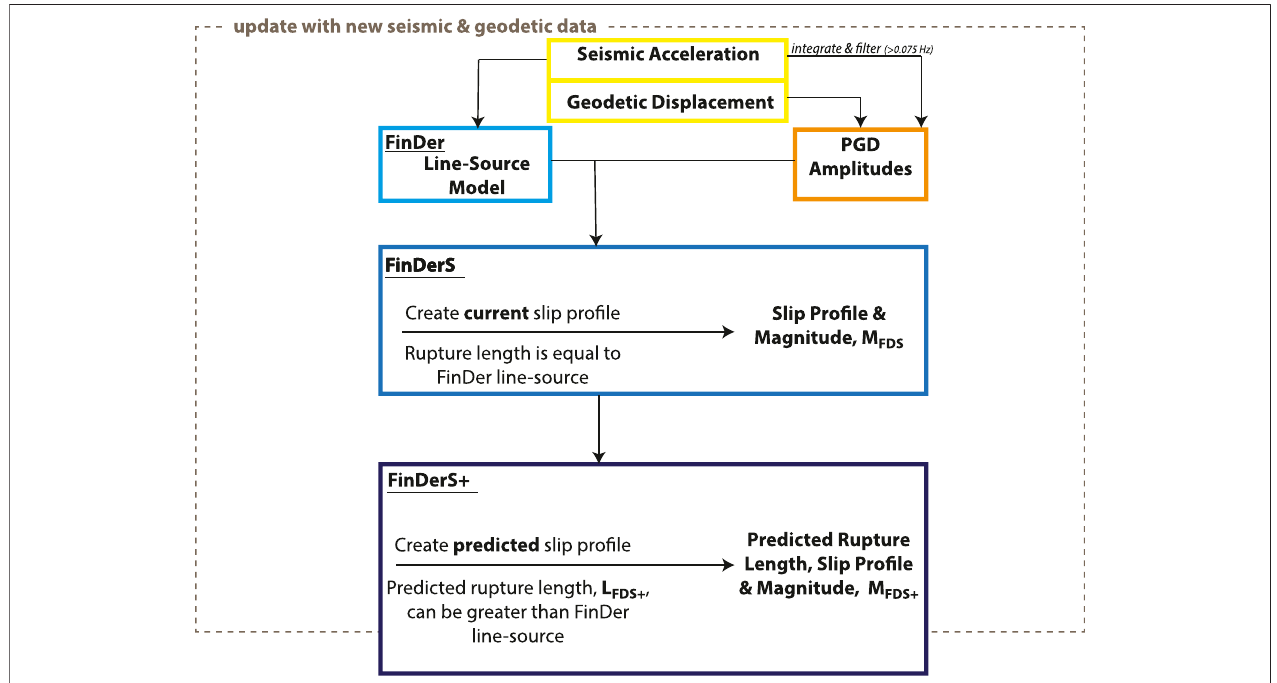
FIGURE 1 | Schematic illustration of FinDer algorithms, including the original FinDer main algorithm that computes line-source models from seismic acceleration data, and the new FinDerS and FinDerS+ algorithms (from top to bottom ). FinDerS determines slip pro fi les by backprojecting peak ground displacement (PGD) amplitudes onto theFinDer line-source.FinDerS+does the same, but allows theline-sourceto growbeyond thecurrentFinDer model. This enables FinDerS+ topredict future rupture growth, while FinDer and FinDerS both characterize the (close to) current rupture state. PGD amplitudes are derived from integrated and high-pass ( > 0.075 Hz) fi lteredseismicstrong-motionand/orgeodeticdisplacementrecords.WeuseagenericempiricalequationderivedinHutchisonetal.(2020)foraninformed interpolation and smoothing of slip values. The two new algorithms provide alternate magnitude estimates that are based on seismic slip, while FinDer magnitudes are computed from the length of the line-source estimate. Together, the three algorithms exploit the full spectrum of ground-motions, including high frequencies to derive a source model (FinDer) and low frequencies to determine the static offsets along this source (FinDerS and FinDerS+).